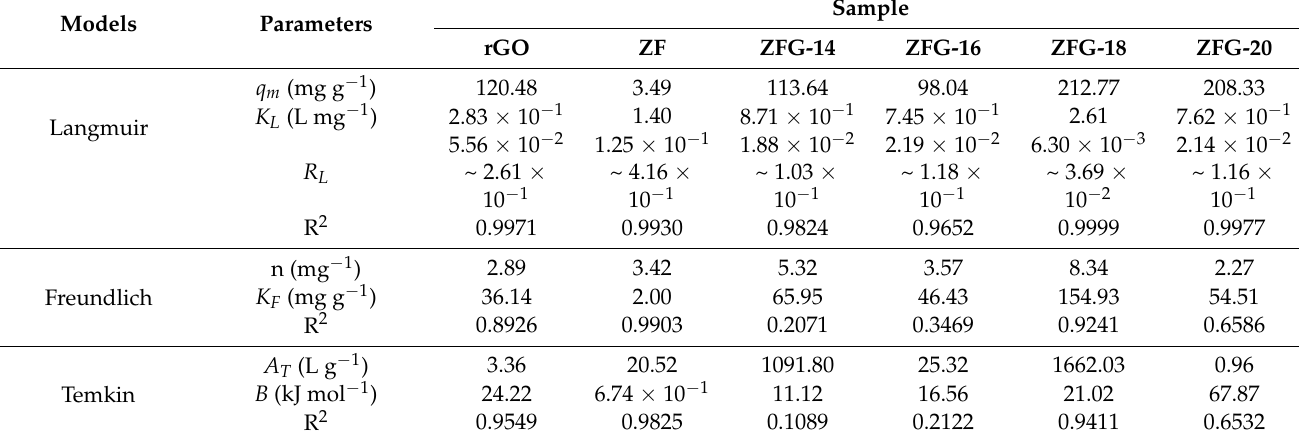
Table 5. Fitting parameters of Langmuir, Freundlich, and Temkin adsorption isotherm of as-prepared samples.